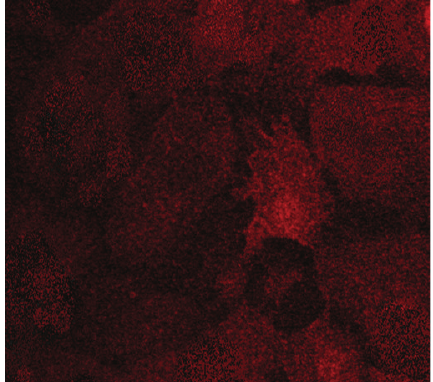
Figure 13: Immunofluorescence image of ERM cells using an antibody to OPN at 24 hours. ERM cells were positive for OPN at 24 hours stretch